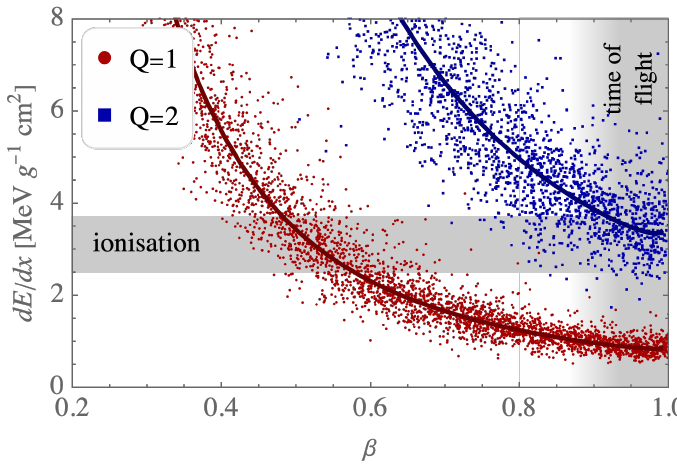
Figure 1 . Distribution of the dE/dx signal as function of β for unit and doubly charged particles. The continuous lines denote the most probable values (2.1). The simulated points are spread around it by the Crystal Ball distribution given in appendix A. The grey bands indicate the regions of the ATLAS excess events, in particular their ionisation dE/dx and β ≈ 1 , as suggested by time-of-flight